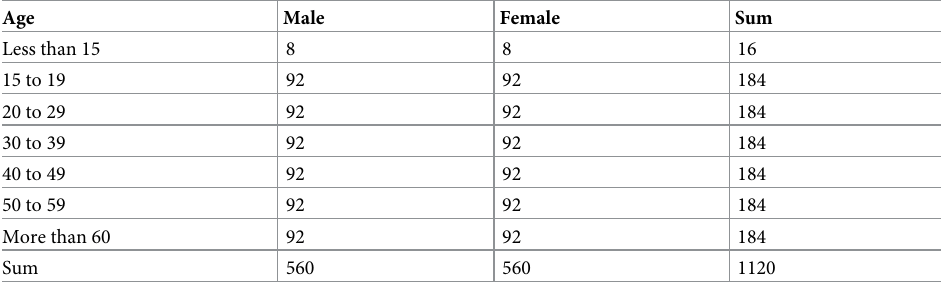
Table 4. Plan of the experiment for the number of subjects (long-term emotion). Age Male Female Sum